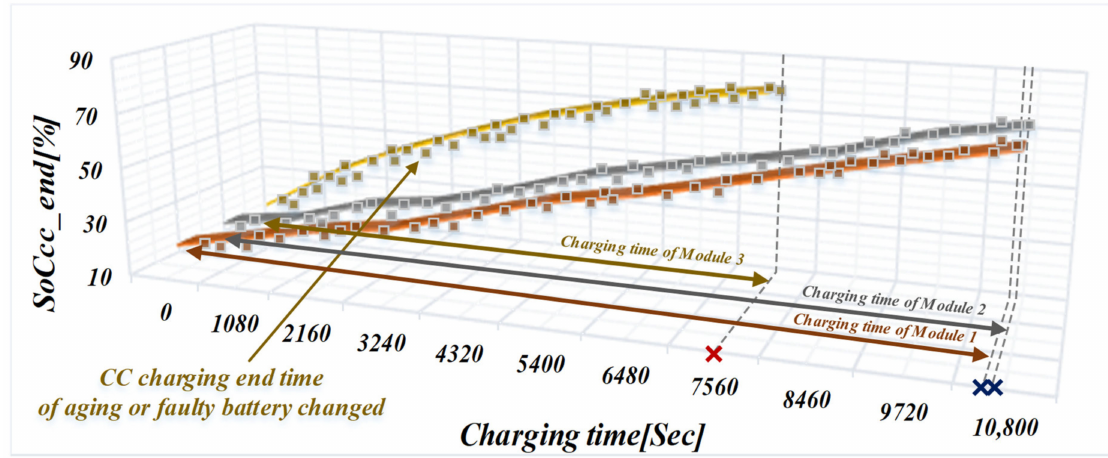
Figure 13. SoH profile with CC charging time, to which the battery efficiency was applied. Table 3. SoH table for three battery modules to which the battery efficiency was applied. Charging Time Charging Time ∆ SoC Parameter (Before) (After) Module 1 10,740 s 10,610 s 0.02% Module 2 10,760 s 10,700 s 0.01% Module 3 10,740 s 7430 s